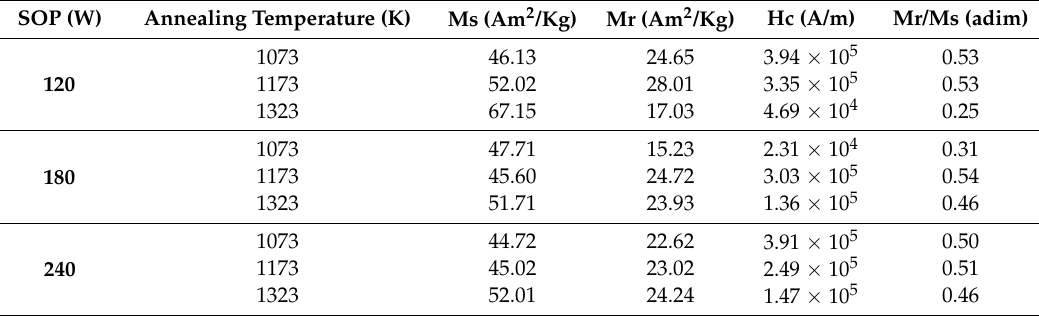
Table 3. Magnetic saturation (Ms), remanent magnetization (Mr), and coercitivity field (Hc) of sonicated powders at 120, 180, and 240 W of SOP thermal